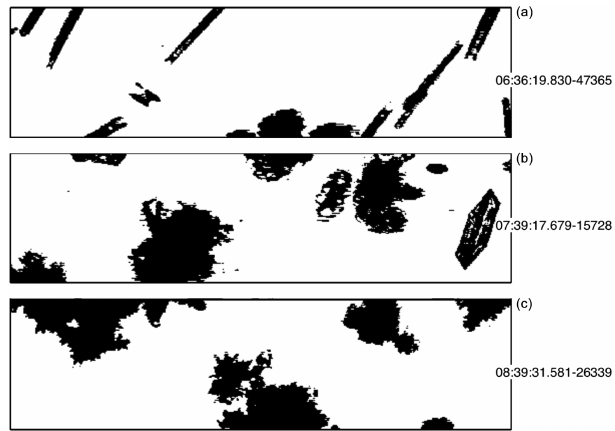
Figure 1. Examples of particle images from the Stratton Park En- gineering Company Two-Dimension Stereo (2D-S) probe, showing the presence of (a) column, (b) plate, and (c) aggregates of den- drites on 13 February 2018. Each image frame is 1.28mm high, taken from one of the probe channels only since the other channel was not working properly on this